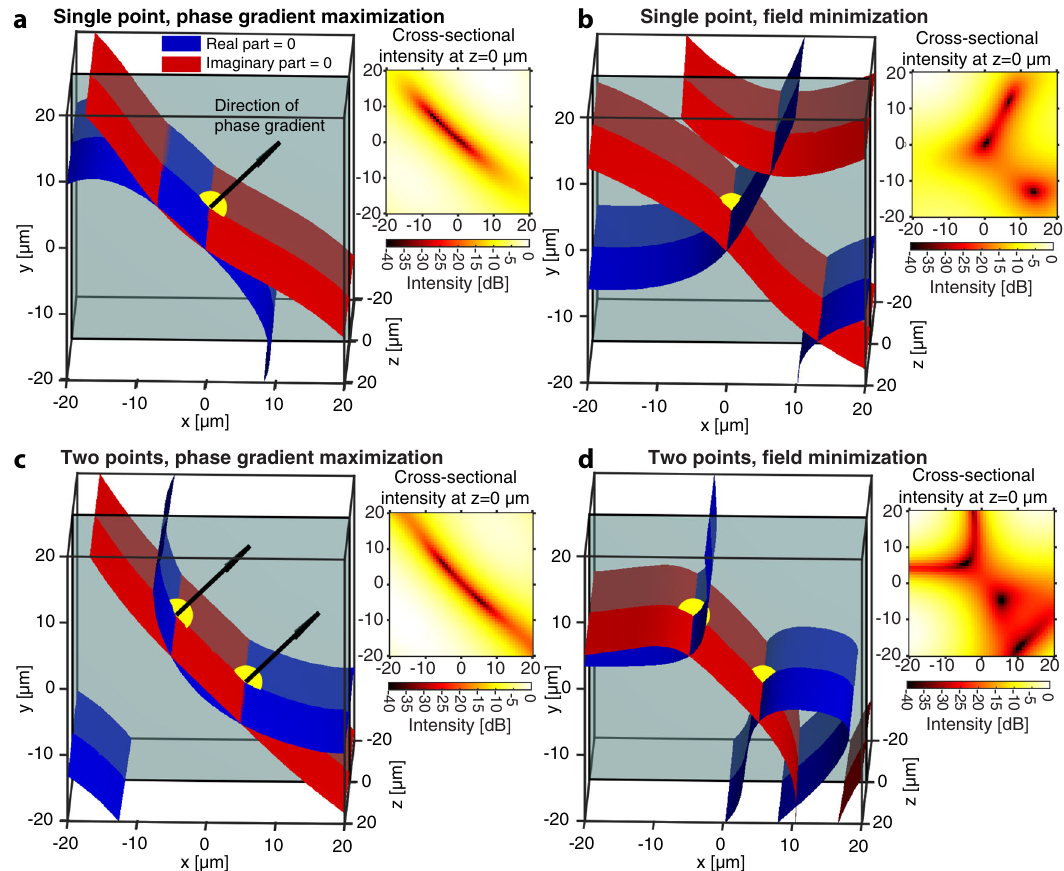
Fig. 2 Comparison between phase gradient maximization and fi eld minimization to obtain phase singularities. Both methods can be used to obtain phase singularities, but they produce different fi eld behavior in terms of its real (blue) and imaginary (red) zero-isosurfaces. Yellow dots label the positions at which the fi eld and phase gradients are optimized. Inset surface plots are the logarithmically scaled fi eld intensities at z = 0 μ m over the same XY domain. The z = 0 μ m plane is indicated with the gray plane in each isosurface plot. a When the phase gradient in a speci fi ed direction is maximized, the two zero-isosurfaces align approximately tangentially and in the direction normal to that speci fi ed gradient. This produces a fl at low fi eld intensity structure along these aligned zero-isosurfaces. b Minimizing the fi eld amplitude at a point to produce a singularity merely enforces a crossing of the zero-isosurfaces without any alignment, producing a 1D line singularity. c Simultaneously optimizing two nearby points with directed phase gradients can extend the range of the singularity sheet. d Minimizing the fi eld amplitude at two points simultaneously does not guarantee alignment of the zero-isosurfaces and can instead produce multiple crossing lines, each producing a 1D line